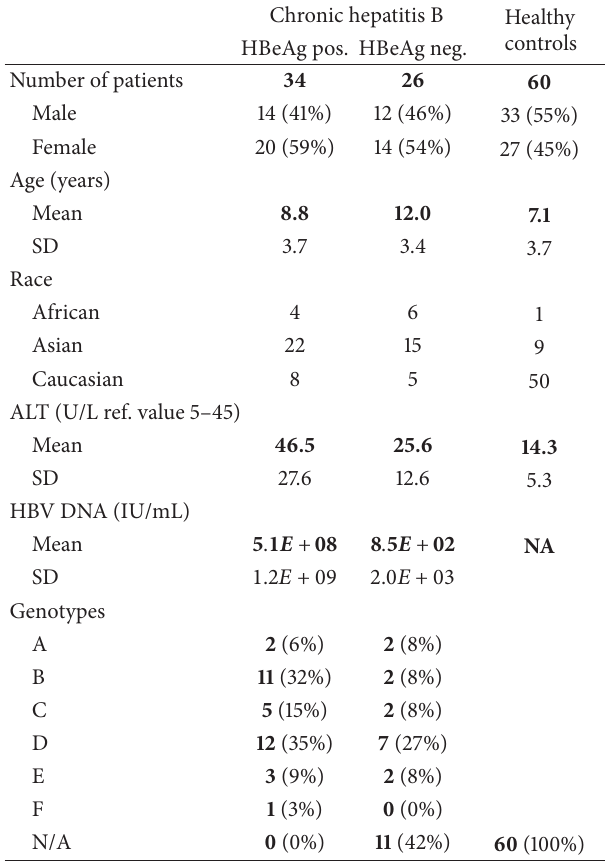
Table 1: Characteristics of children with chronic hepatitis B and of healthy controls